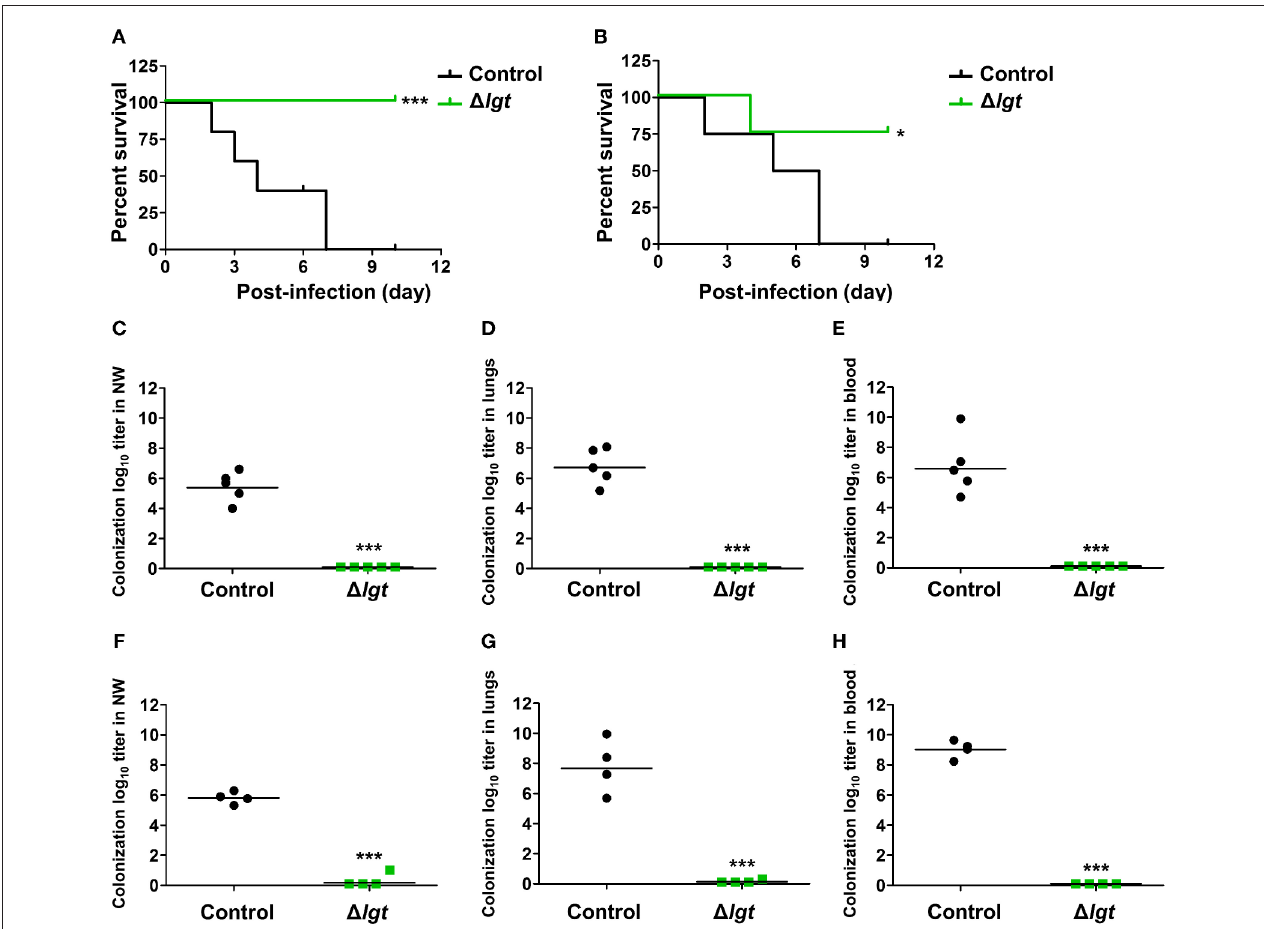
FIGURE 5 | Serotype-independent protection conferred by TIGR4 1 lgt vaccination. (A,B) Survival of mice ( n = 5) i.n. immunized with 1 lgt (10 6 CFU) twice at 14-day intervals, followed by i.n. challenge with 10 8 CFU of wu2 (A) or D39 (B) strains. (C–H) Pneumococcal numbers counted within serially diluted nasal washes (C,F) , lung tissue homogenates (D,G) , and blood (E,H) from 1 lgt (10 6 CFU)-immunized mice challenged with wu2 (C–E) or D39 (F–H) . * P < 0.05 and *** P < 0.001 compared to the control group immunized with